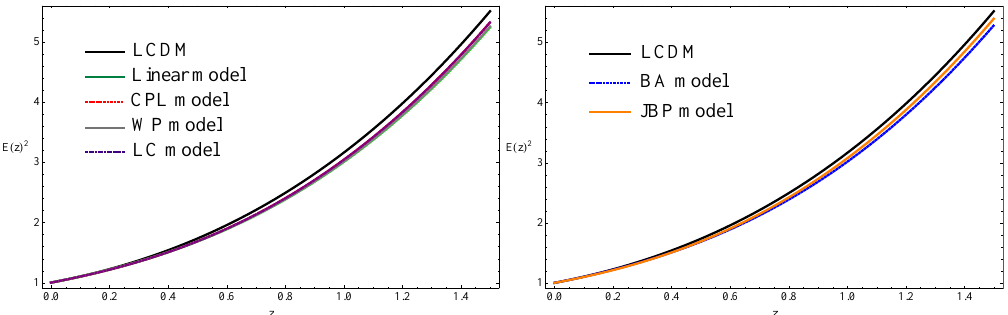
Figure 2. E ( z ) 2 evolution function for each dark energy parameterizations. We use the best fit obtained in each parameterizations with the SNe Ia JLA+BAO joined dataset. Left: Evolution of Equation (3) and the bidimensional dark energy parameterizations Equations (5), (7) and (15). Right: Evolution of the Equations (3) and the bidimensional dark energy parameterizations (9)–(13) (with z 2 -terms in w ( z )